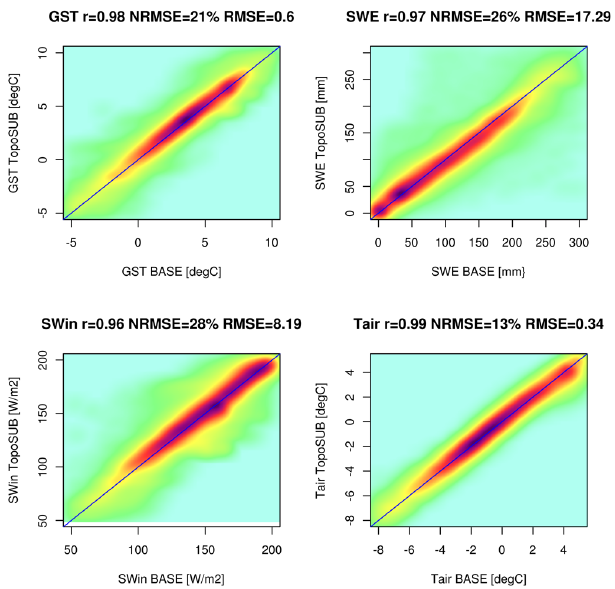
Fig. 10. Density scatter plot of TopoSUB/BASE after informed scal- ing and fuzzy spatialisation at 258 samples. Data presented is mean annual value for each pixel in the simulation domain. All TVs are reproduced with low error as reported by the correlation coefficient ( r ) and RMSE (computed over 10 6 pixels). The diagonal line rep- resents y = x .